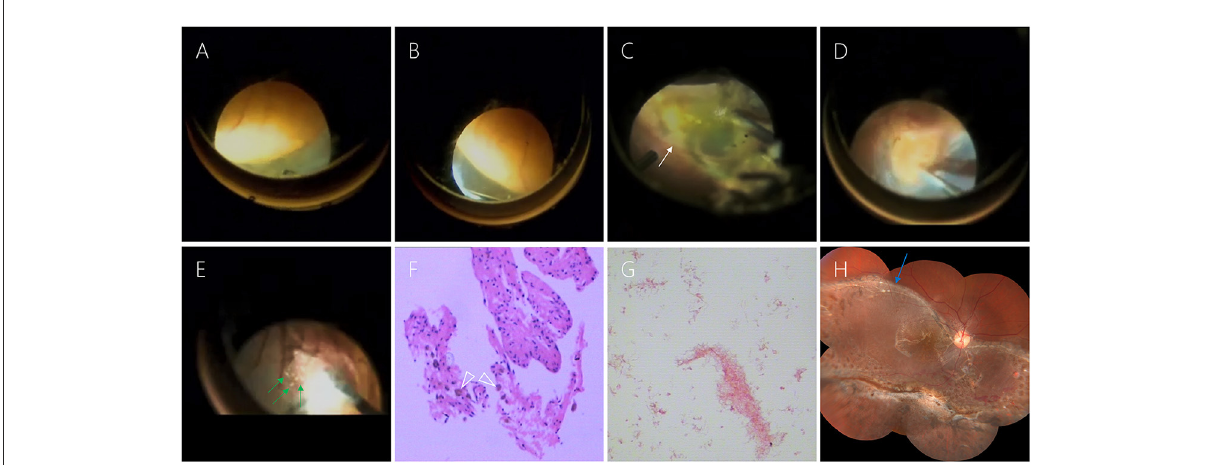
FIGURE2 (A, B) The giant cyst was located in the inferior peripheral area from 4 to 8 o’clock. (C) There was a clear boundary of epithelial atrophy (white arrow) between the detached retina and the normal one. (D) After removing the upper retina, we can see the apparent cyst wall. (E) Colored crystalline fluid (green arrow) flowed from the cyst when the retina and the wall were incised. (F) The pathological results of the cyst wall revealed a small amount of retinal tissue and pigmentation (white triangle). (G) The abscission cytology test of the crystalline liquid excluded the presence of nucleated cells. (H) Six months after the first surgery, the retina had been repositioned. The boundary between the normal retina and the detached retina that appeared earlier could be visualized (blue